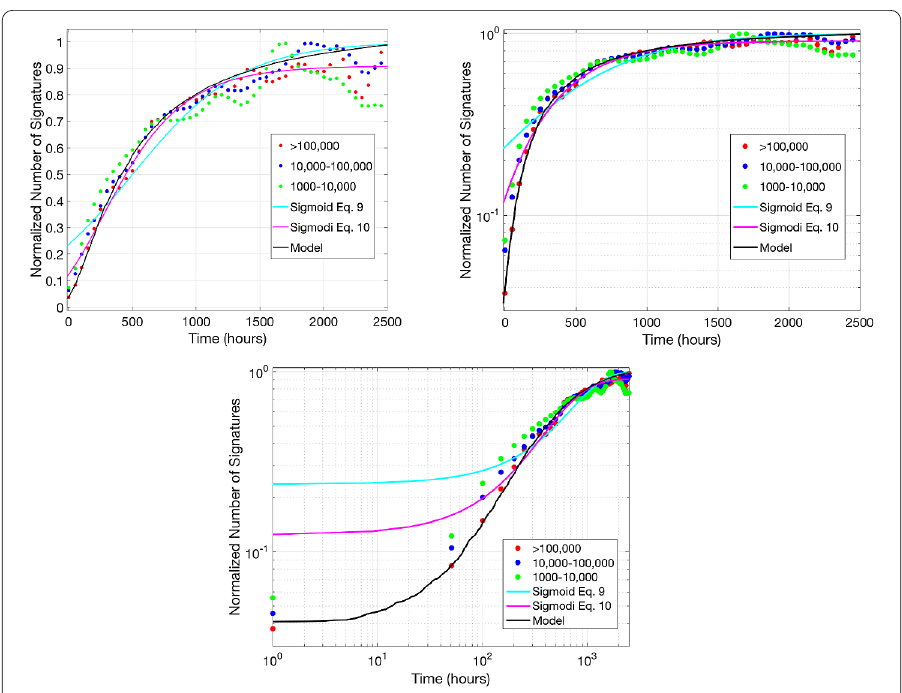
Figure 7 Data collapse of the normalized number of signatures for different cohorts of petitions . The model fits the data much better than a Sigmoid